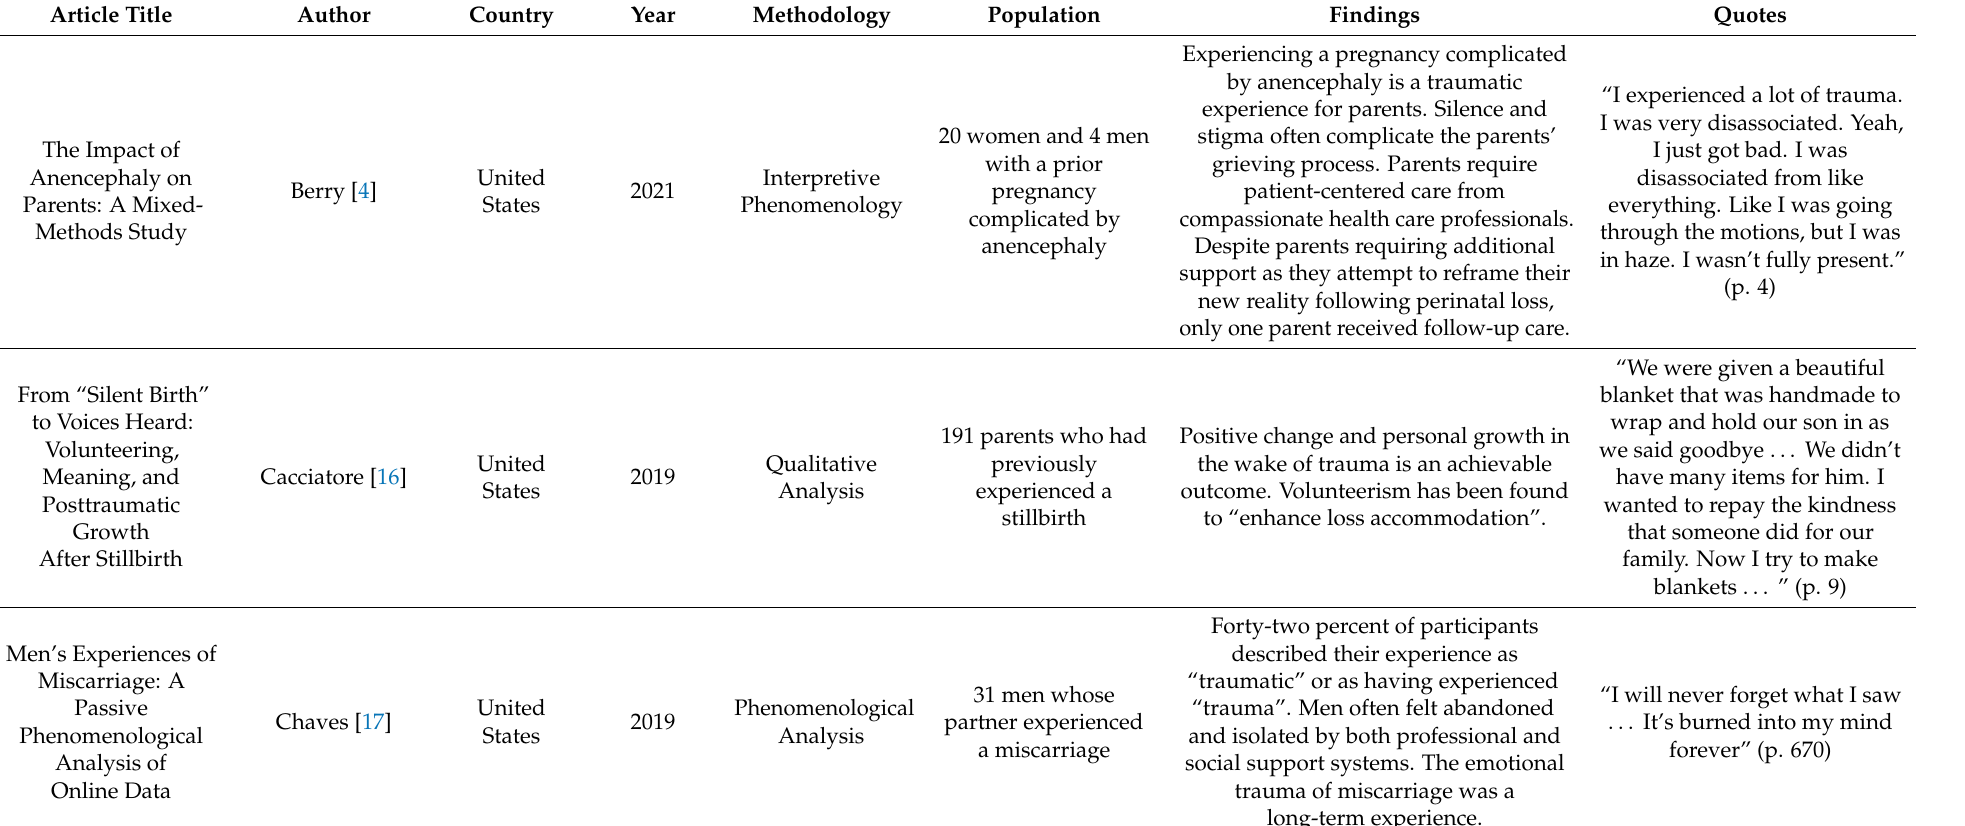
Table 1. Summary of Article